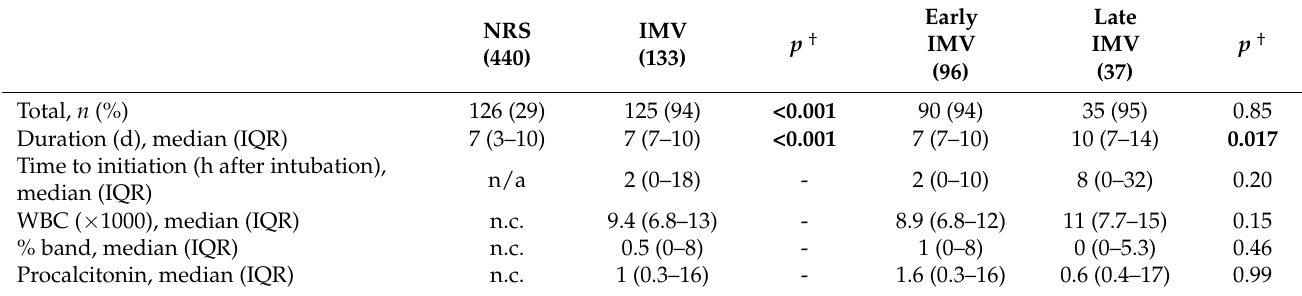
Table 4. Antibiotic Usage, Lab Results (all groups, n =